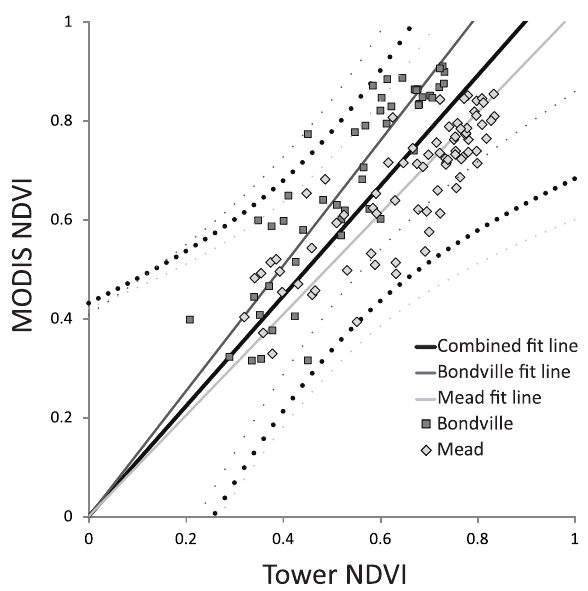
Fig. B3. MODIS NDVI as a linear function of Tower NDVI based on observations made at the Mead, NE, and Bondville, IL, rain- fed sites from 2002–2007. (MODIS NDVI = 1.113 *Tower NDVI, r 2 = 0 . 69 and RMSE =